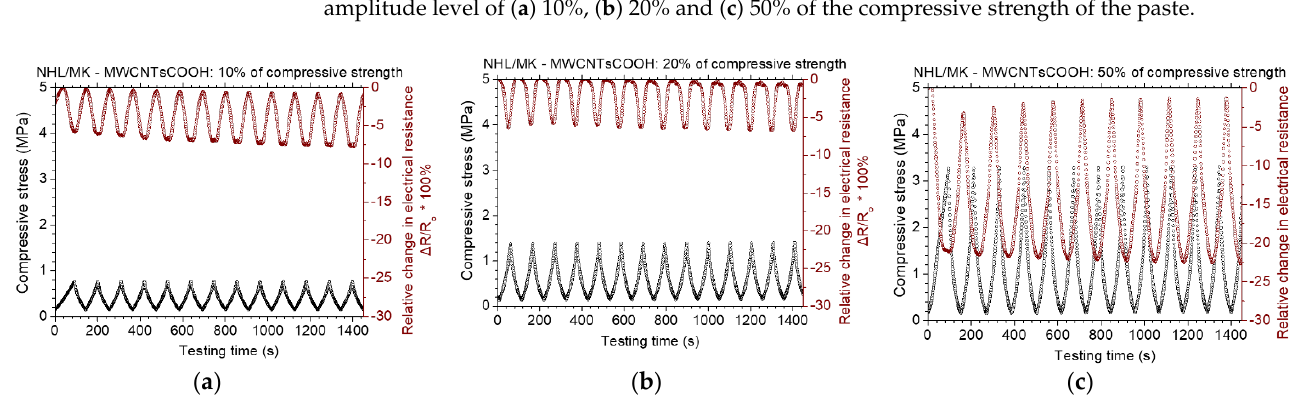
Figure 14. Cyclic, piezoresistive response of MWCNTsCOOH reinforced binary paste at constant amplitude level of ( a ) 10%, ( b ) 20% and ( c ) 50% of the compressive strength of the paste.